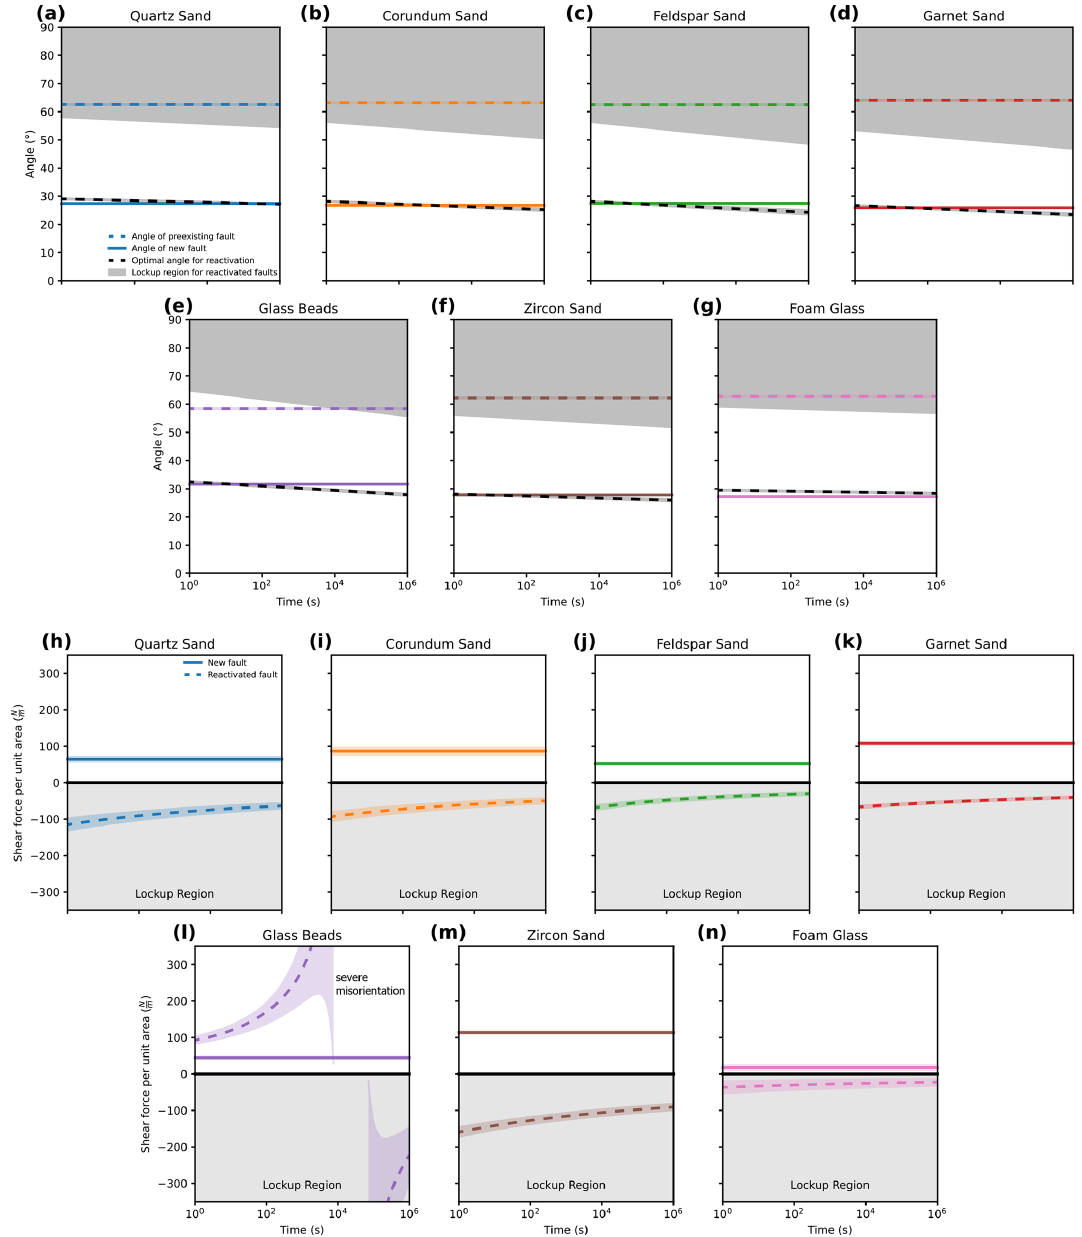
Figure 6. Optimal angles and shear forces for new and reactivated faults. (a) – (g) Optimal angles of faults for each material. (h) – (n) Shear forces required to move a wedge of material along a new and reactivated fault. Errors are derived from the uncertainties of the parameters and represent 2 σ